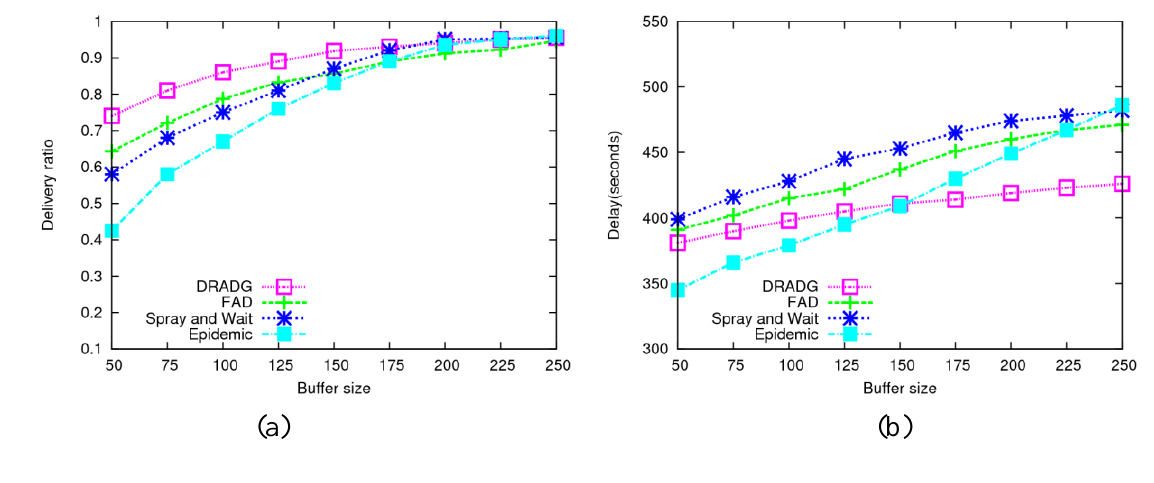
Figure 4. Impact of buffer size. (a) Average delivery ratio; (b) Average